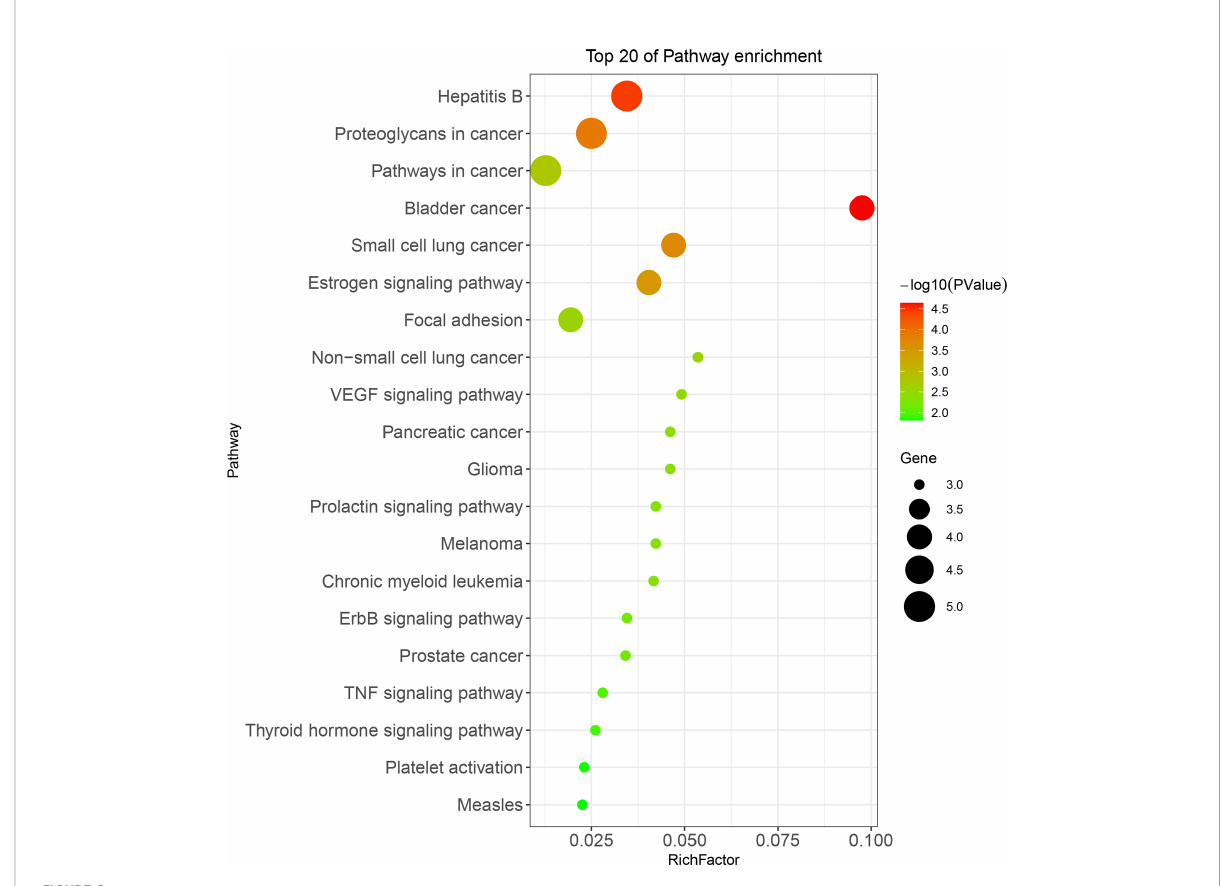
FIGURE 6 KEGG pathway analysis for 12 CKI anti-BC